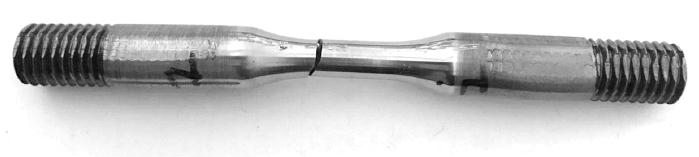
Figure 14. Sample after fatigue test.